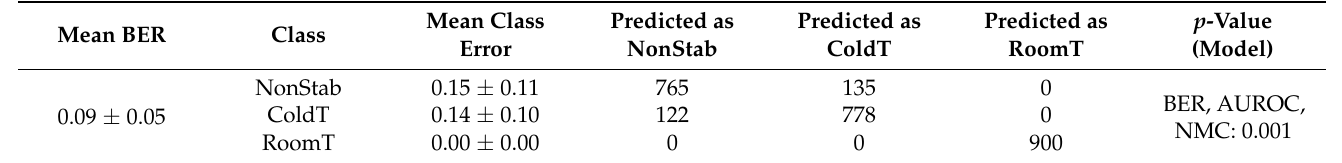
Table 1. Multilevel partial least squares discriminant analysis (ML-PLS-DA) performance (from a double cross-validation